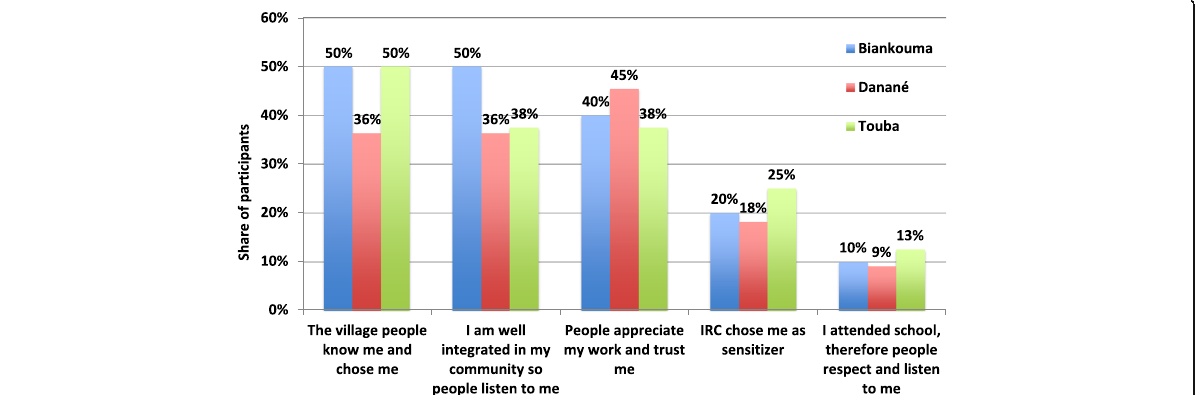
Fig. 3 Most important reasons for sensitizers ’ legitimacy across districts, according to participatory workshops participants. Percentages represent the share of participants rating the attribute in the top range, on a scale from 1 to 5, in terms of how important it is to